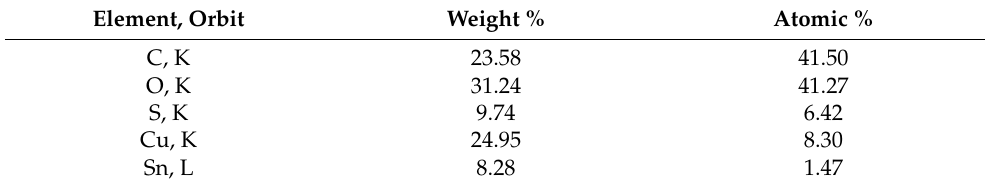
Table 2. EDX element analysis table for CuSn-OC.